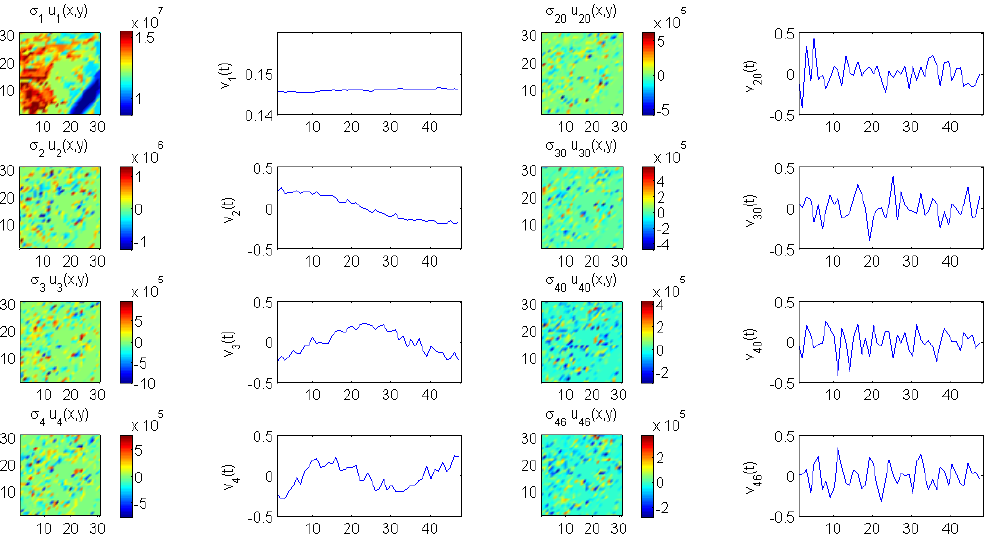
Figure 5. Topos–Chronos decomposition of pre-flare solar activity. Odd columns: spatial modes u k (r i ) ; even columns: temporal modes v k (t j ) , for k = 1, 2, 3, 4, 20, 30, 40, 46. One unit on the time axis equals